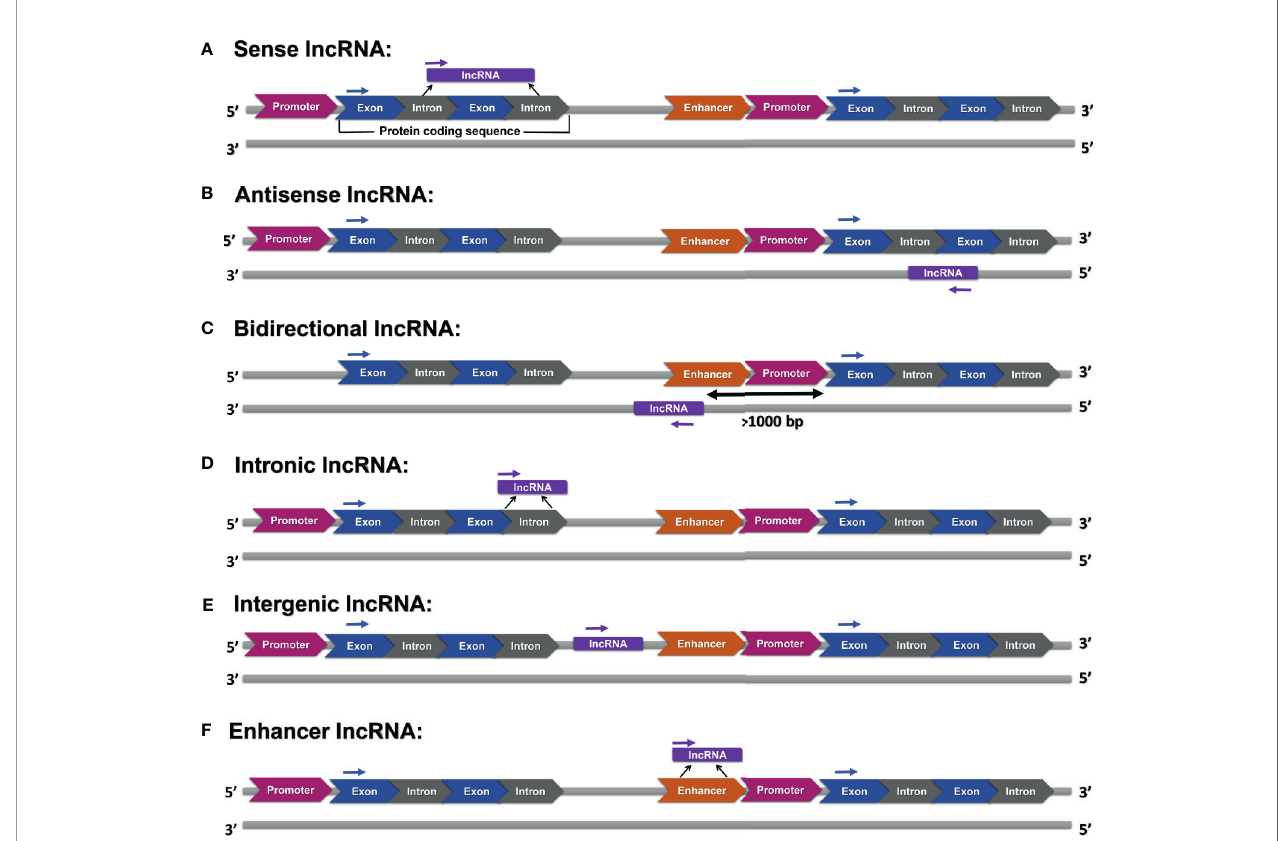
FIGURE 1 | Various categories of lncRNAs: (A) sense lncRNAs are transcripts of one or more exons of protein-coding genes, (B) antisense lncRNAs are transcripts of the opposite strand of protein-coding or non-protein-coding genes, (C) bidirectional lncRNAs are transcribed in an opposite direction, and their transcription is initiated at more than 1000 base pairs (bp) far from the promoter region of a protein-coding gene, (D) intronic lncRNAs are transcribed from introns, (E) intergenic lncRNAs are transcribed from sequences without any overlap with annotated protein-coding genes, and (F) enhancer lncRNAs are produced from enhancer